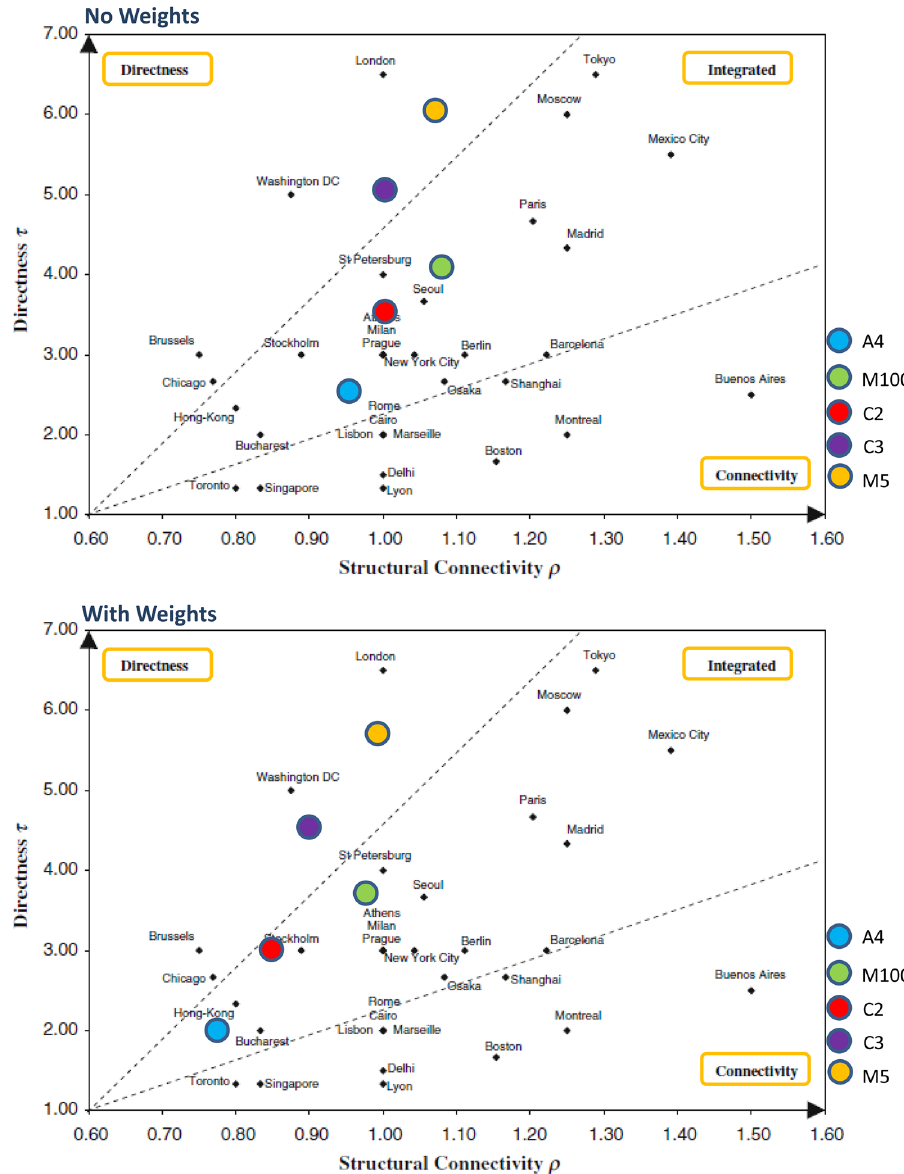
Fig. 3 Network integration